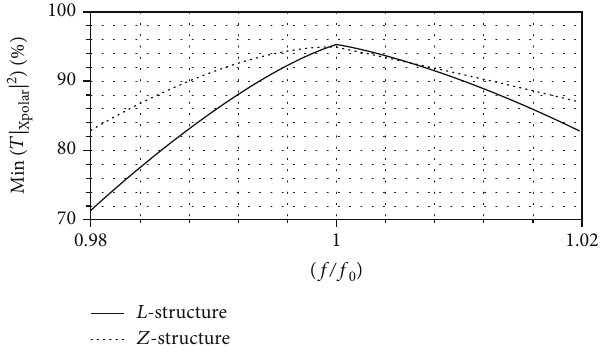
Figure 8: Minimum power conversion of the proposed LP converters with respect to the direction of incident wave polarization.